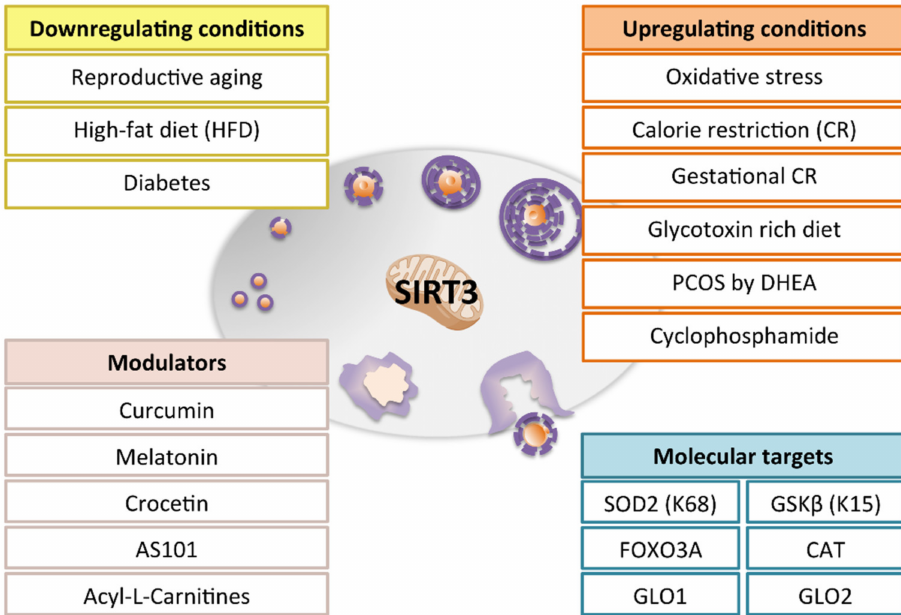
Figure 3. Modulation of SIRT3 in the ovary. The figure shows that SIRT3 expression can be dif- ferentially modulated under non-physiological conditions. Reproductive aging, high fat diet and diabetes are conditions that induce a reduction of SIRT3 levels in the ovary. On the other hand, oxidative stress, calorie restriction, gestational calorie restriction, glycotoxins rich diet, PCOS, and chemotherapy (e.g., cyclophosphamide) promote SIRT3 increase, probably favoring an adaptive response. Treatments with beneficial effects on ovarian physiology are associated with restoring of SIRT3 ovarian levels. C urcumin and melatonin administration increases SIRT3 expression and amelio- rate the aging phenotype. Crocetin or AS101 prevents ovarian SIRT3 up-expression in mice subjected to chemotherapy. Acyl-L-carnitine counteracts SIRT3 increase in ovaries from PCOS mice. Among SIRT3 molecular targets, SOD2, GSK β , FOXO3A, catalase and glyoxalases have been proposed as downstream effectors of SIRT3 in the female